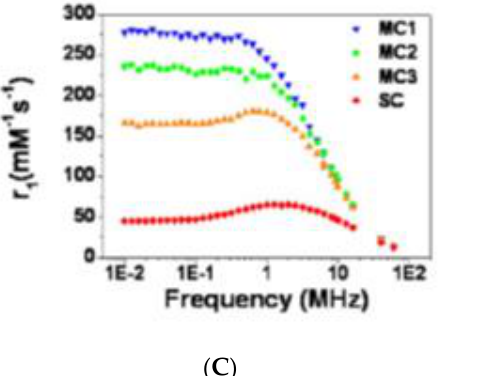
Figure 32. ( A ) Field amplitude dependence of the specific absorption ratio (SAR) for MMCs with decreasing diameter from MC0 to MC3 (MC0 (cyan), MC1 (blue), MC2 (green), MC3 (orange)) and magnetic single core nanoparticles (red), ( B ) SAR comparison between MC0 sample and commercial BNF starch for four frequency values, ( C ) Frequency dependence of r 1 relaxivities, and ( D ) r 1 and r 2 relaxivities (reprinted with permission from [75]. Copyright 2012 American Chemical Society).